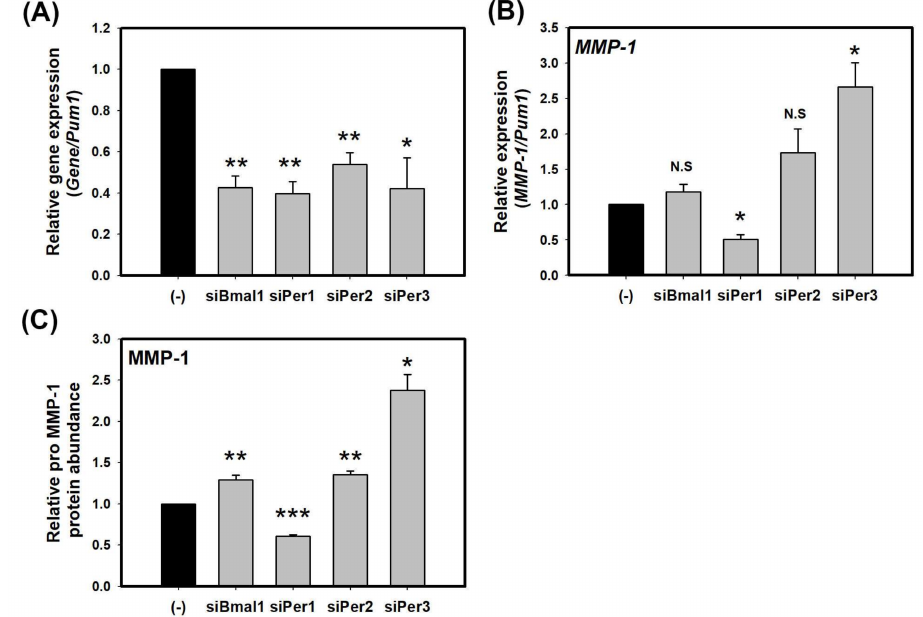
Figure 1. Core clock proteins regulate the expression of MMP-1 in HaCaT cells. ( A ) Transcriptional levels of endogenous clock genes in HaCaT cells transfected with control-siRNA, siBmal1, siPer1, siPer2, and siPer3 for 72 h; ( B ) Levels of MMP-1 transcripts in HaCaT cells transfected with control-siRNA, siBmal1, siPer1, siPer2, and siPer3 for 72 h; ( C ) Levels of pro MMP-1 proteins in cell supernatants of HaCaT cells transfected with control-siRNA, siBmal1, siPer1, siPer2, and siPer3 for 72 h. Data are presented as mean ± SEM from three replicated measurements. Data is the relative value compared with control group. (Two-tail unpaired t -test, n = 3, * p < 0.05, ** p < 0.01, *** p < 0.001 compared with control-siRNA, N.S.: not